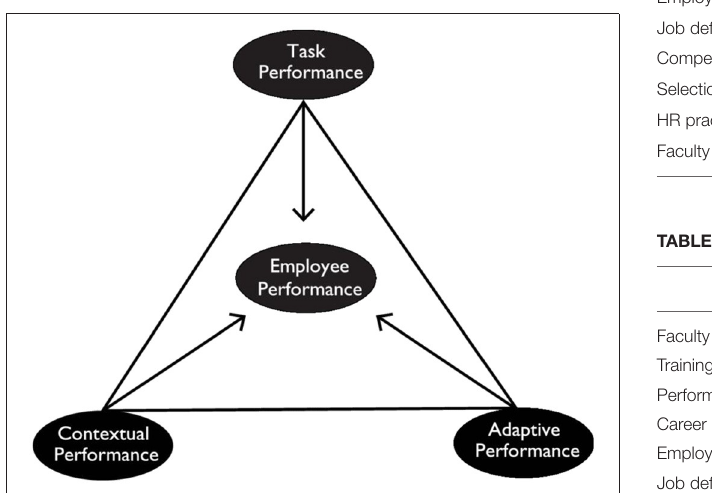
FIGURE 2 | The Triarchy model of employee performance. Source: Pradhan et al.